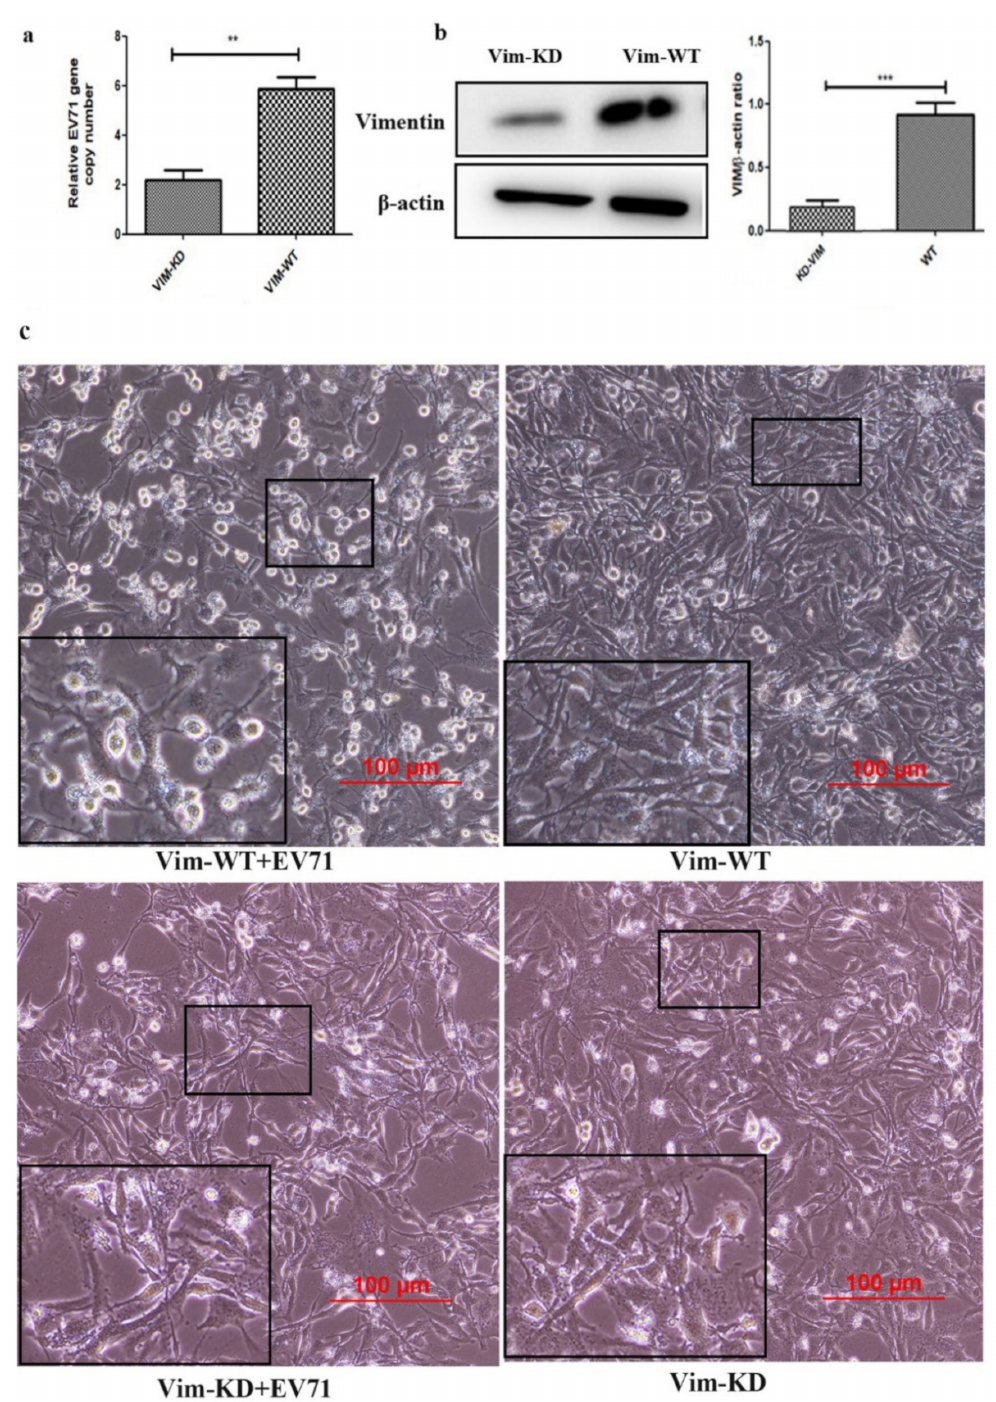
Figure 6. Vimentin mediates the CPE of EV-71 infection. ( a ) Quantitative real-time PCR assay of EV71 replication in VIM-WT and VIM-KD U251 cells. ( b ) The expression of vimentin in VIM-WT U251cells is much higher than that in VIM-KD U251 cells, analyzed by gray analysis of Western immunoblotting. ( c ) Morphological profiles of U251 cells (left: VIM +/+ cells infected with EV-71; middle: VIM − / − cells infected with EV-71; right: uninfected U251 cells). ** p < 0.01, *** p < 0.0001. 2.5. A Proposed Schematic of EV71-Mediated NLRP3 Inflammasome Activation